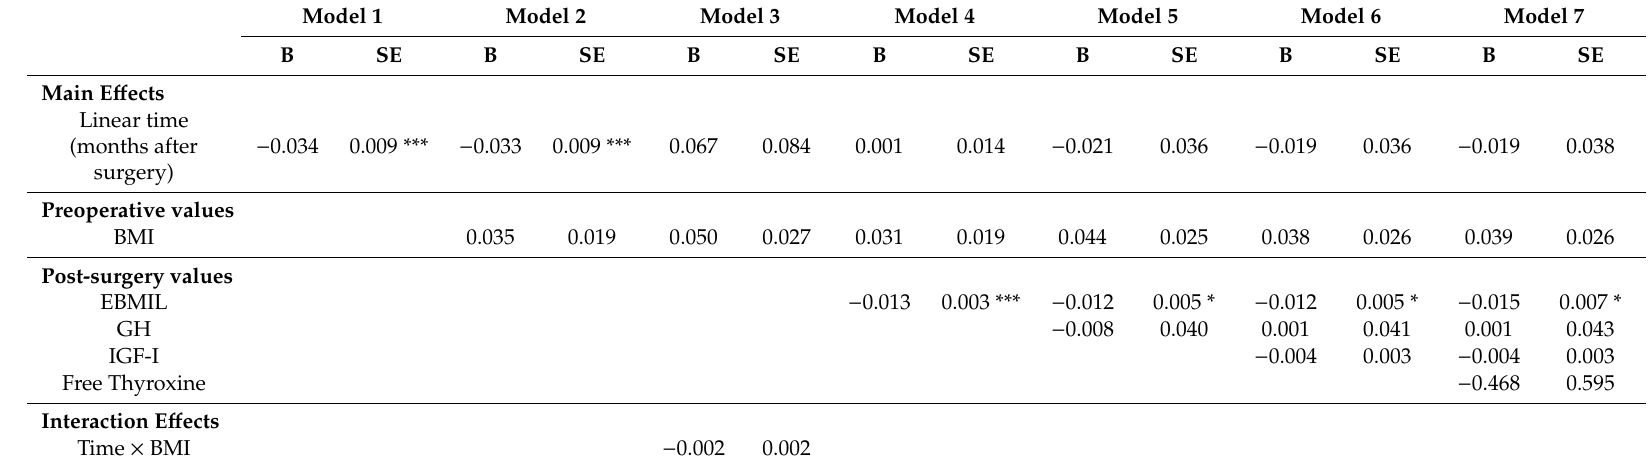
Table 4. Generalized estimating equation models examining trajectory of TSH